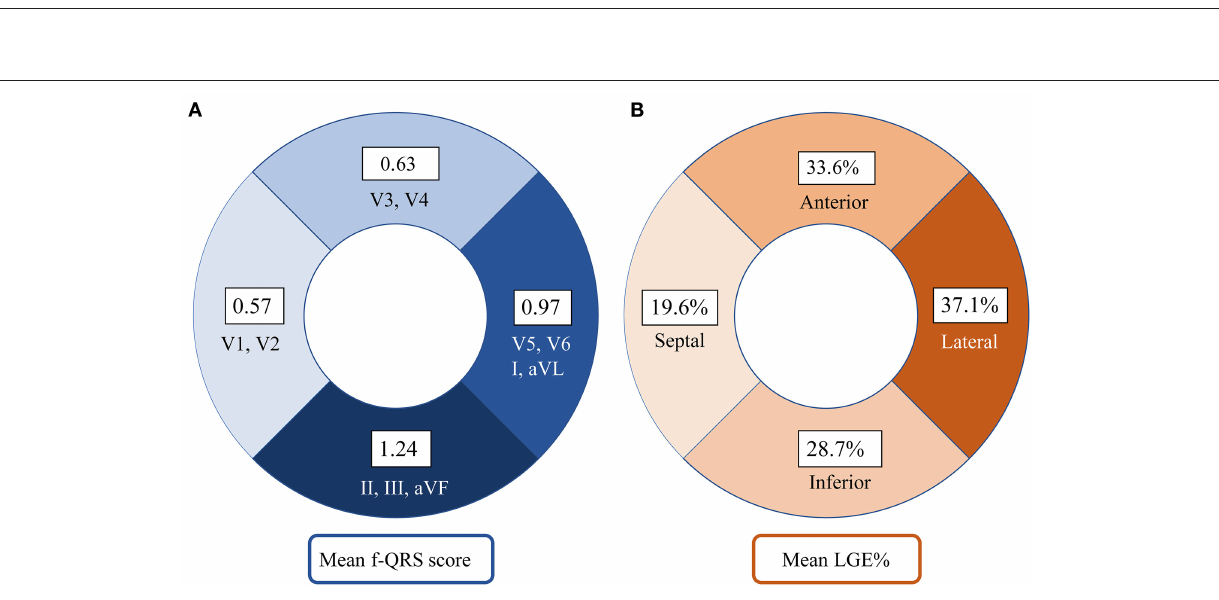
Frontiers in Cardiovascular Medicine | www.frontiersin.org